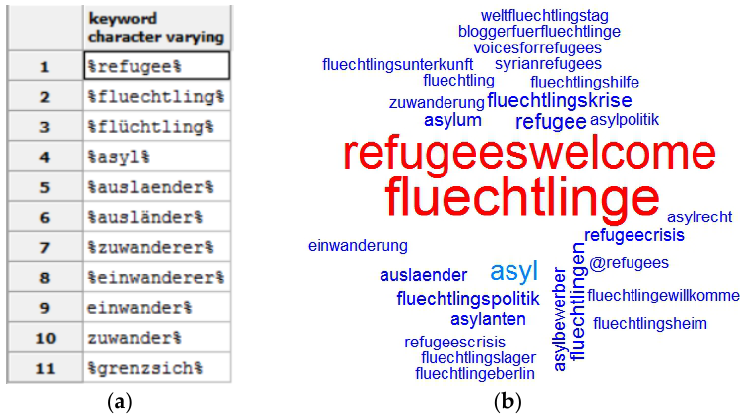
Figure 10. Part of the refugee related keyword list for Austria and Germany ( a ); and corresponding word cloud of hashtags ( b ).